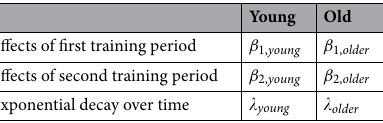
Table 3. Parameters of interest in nonlinear mixed model estimating the effect of training on